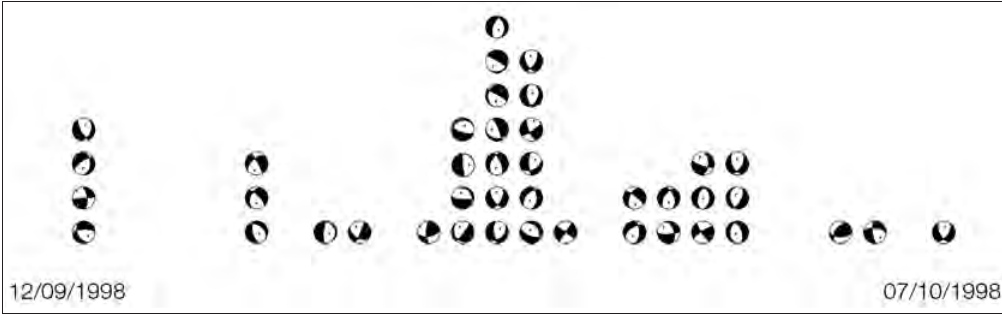
Fig. 10. Fault plane solutions for 41 selected aftershocks in the time interval 12/09/1998-07/10/1998. FPS for events in the same day are in an unique column, at height increasing with